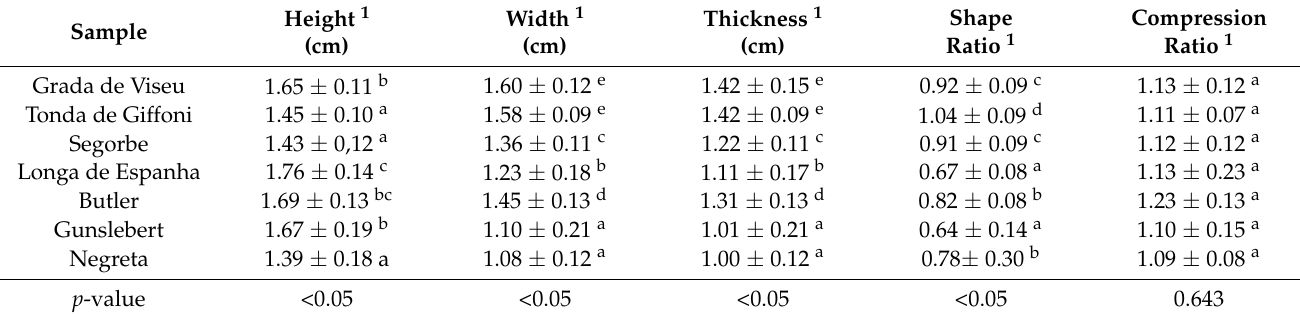
Table 2. Biometric measurements of the hazelnut kernels (mean ± standard